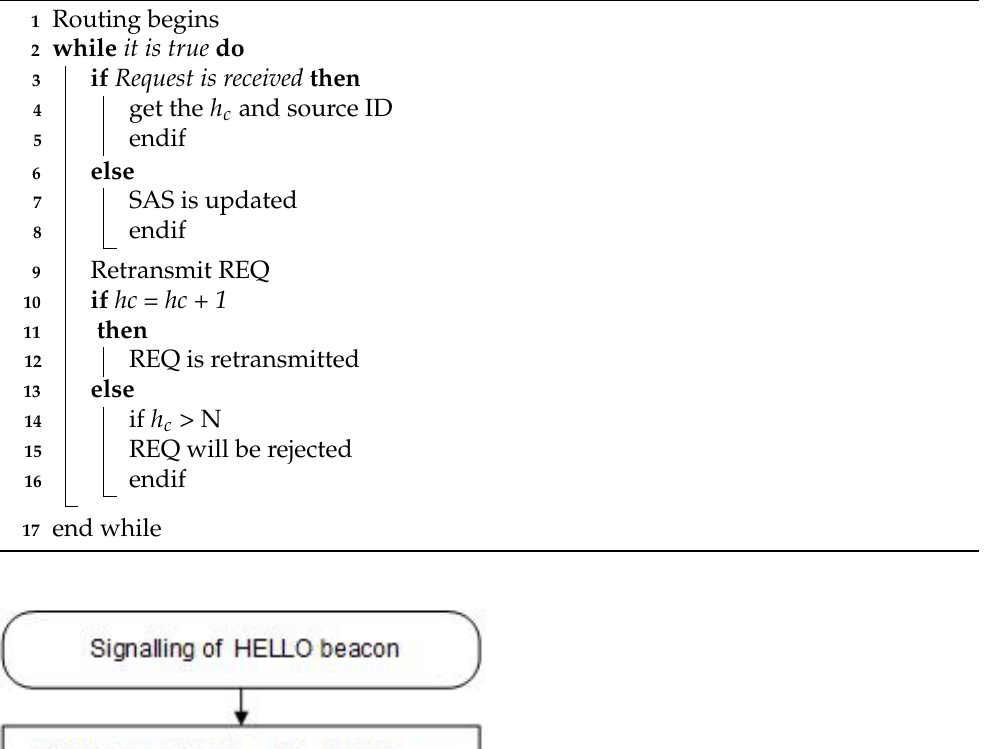
Algorithm 3: Multi-hop message routing.